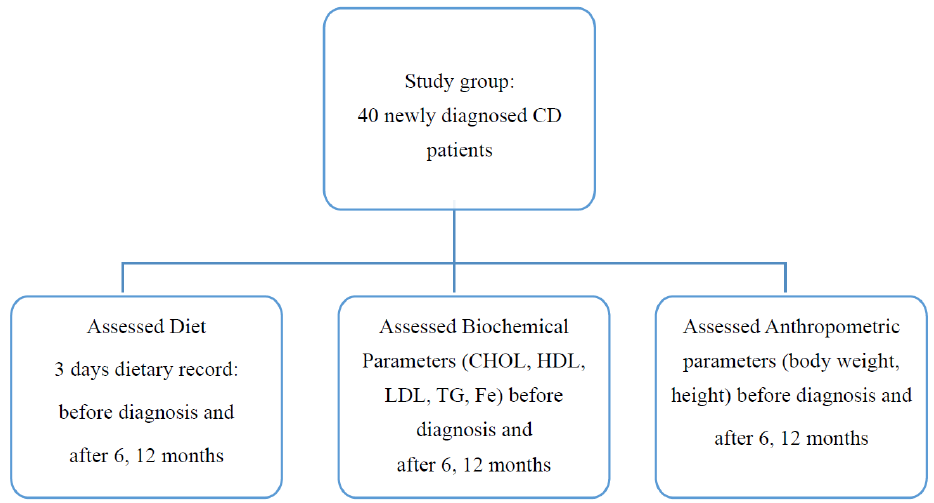
Figure 1. Flowchart of study design.